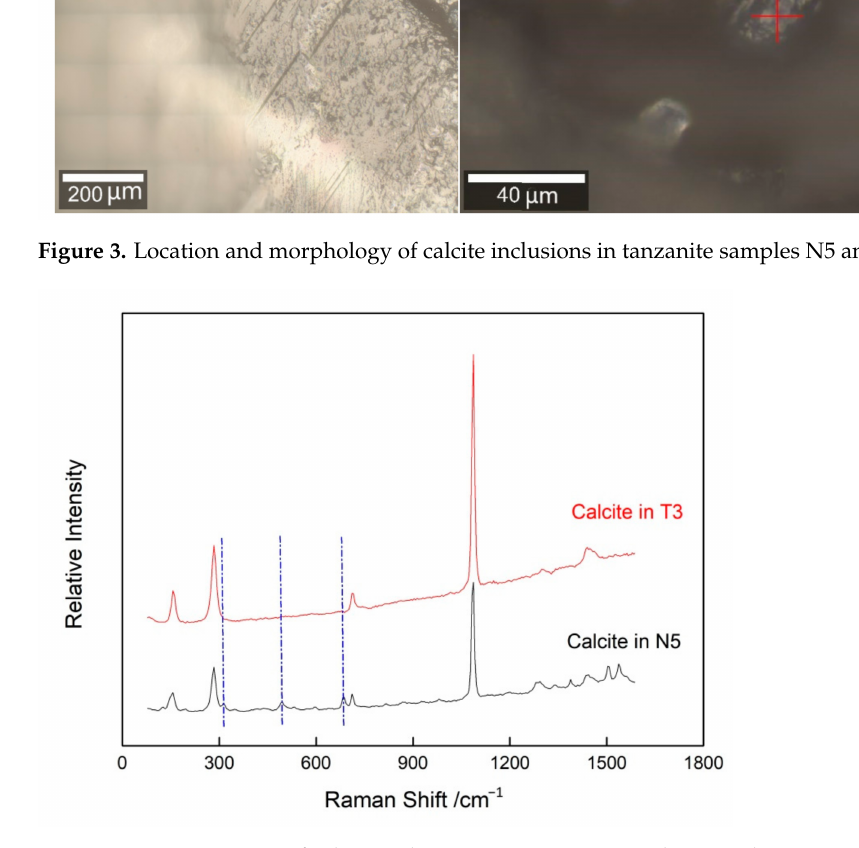
Figure 4. Raman spectra of calcite inclusions in tanzanite sample N5 and